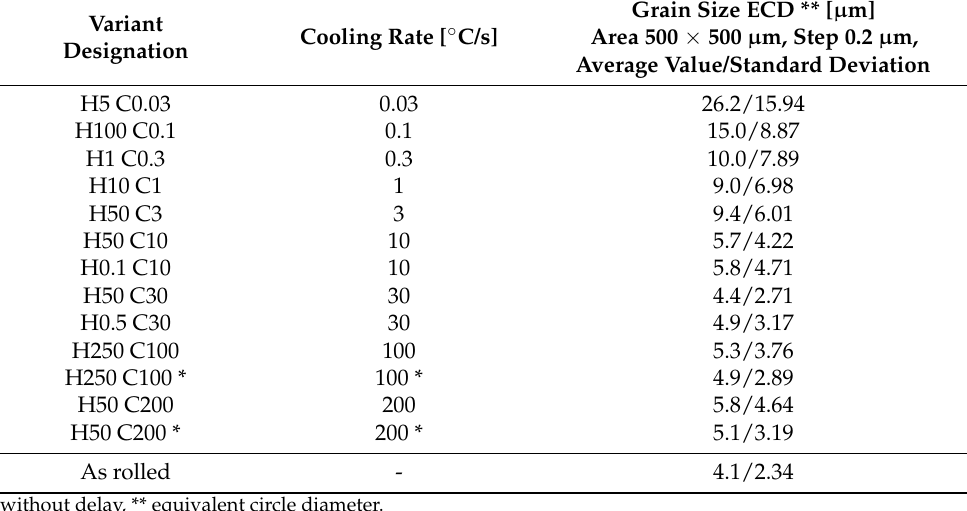
Table 9. The chosen variants for analyzing the final microstructure, hardness, and austenite trans- formation temperatures in the cooling phase.